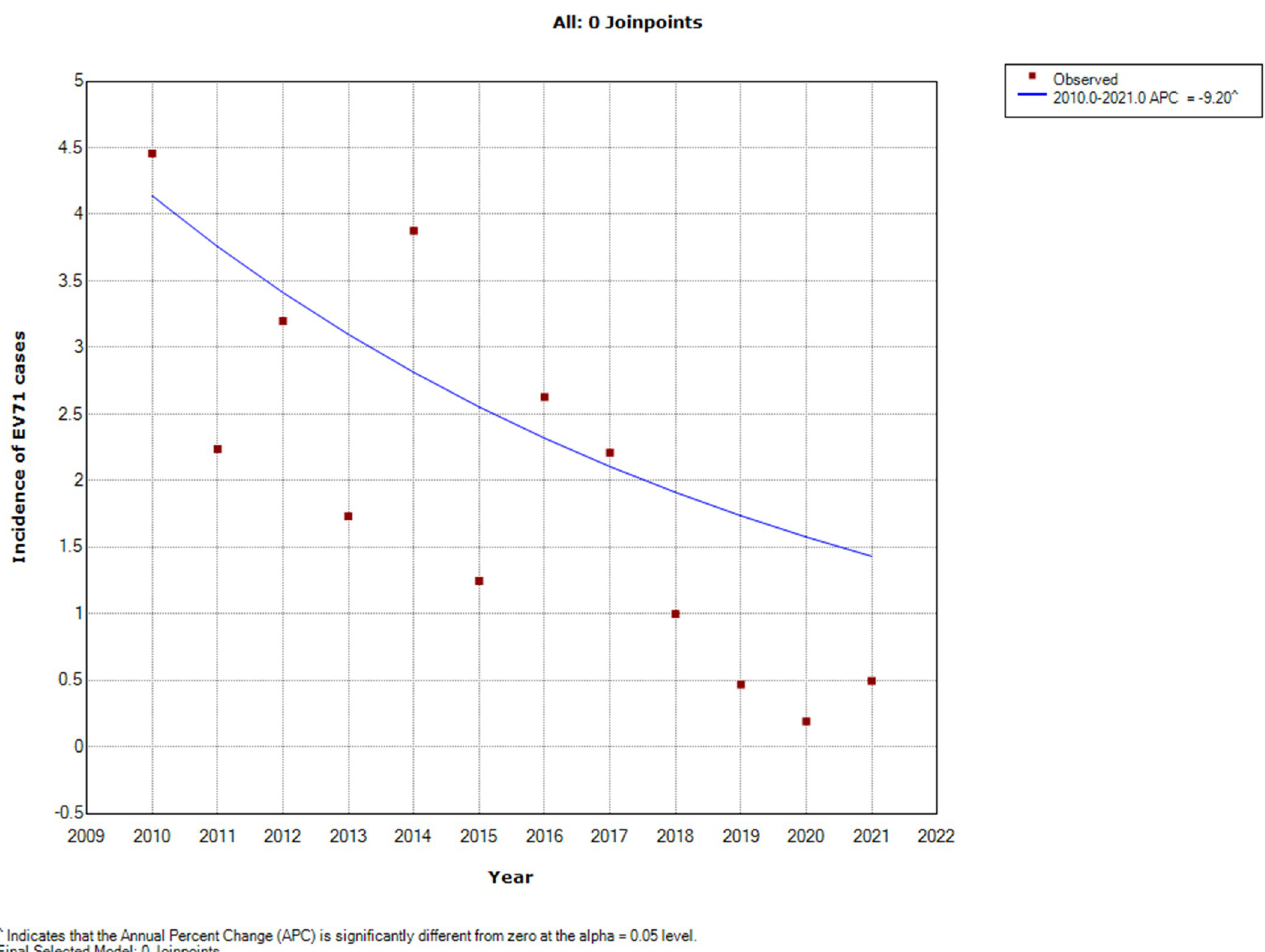
Fig 1. Trend of the incidence of EV71 cases between 2016 and 2021 shown by joinpoint regression. The red squares denote the observed values of the incidence, and the blue line is the slope of the APC. The APC was the annual percent